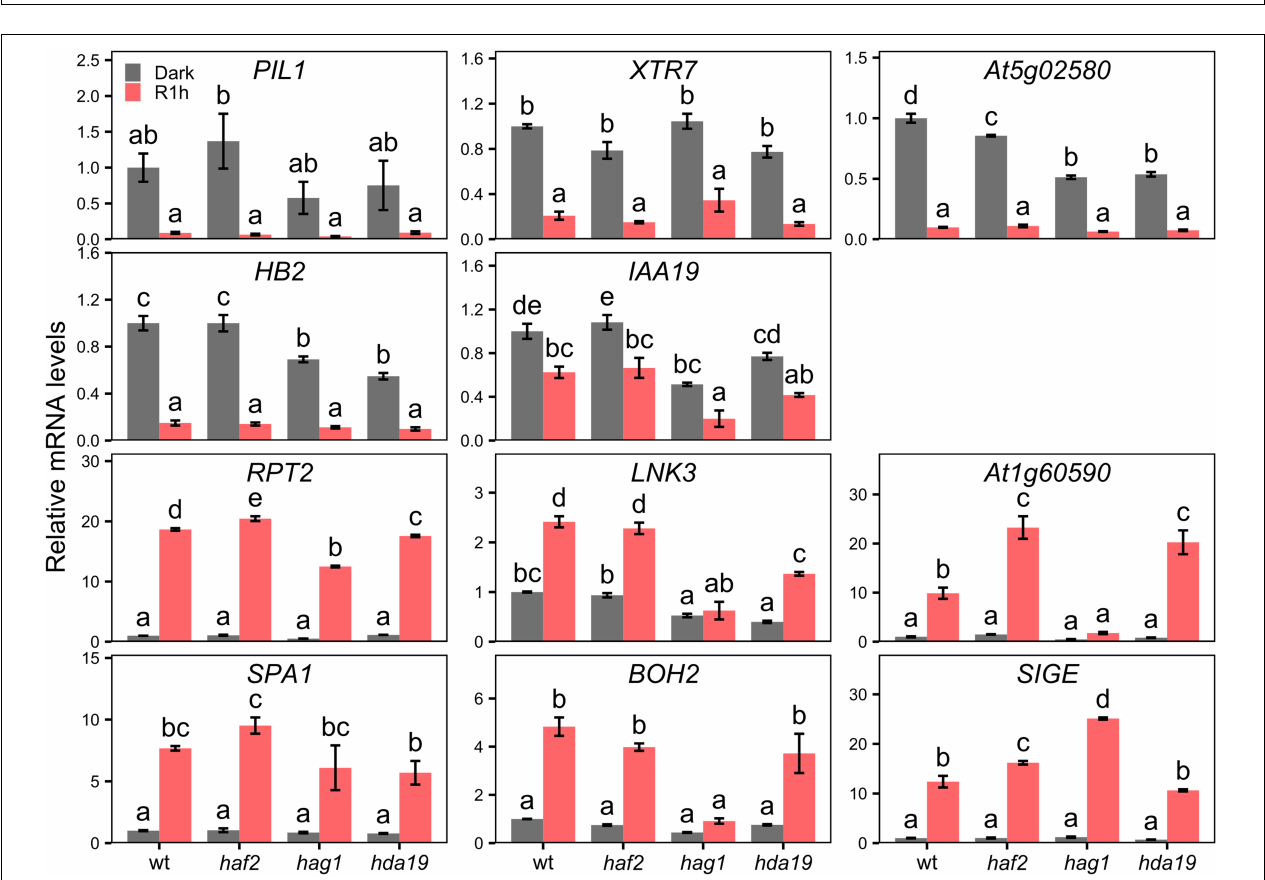
FIGURE 6 | LRP-DTGs short-term transcriptional response to light is not generally affected in histone writer and eraser mutants. mRNA levels measured by RT-qPCR of LRP-DTGs in 3 days old seedlings grown in true dark or grown in the dark and then treated for 1 h with red light (R1h). mRNA levels are normalized to dark-grown wild-type. Error bars represent standard error of the mean. Statistical significance was determined by one-way ANOVA between each genotype and light treatment combination independently for each gene, with post hoc Tukey HSD test. Letters denote significant differences among means ( n = 3).